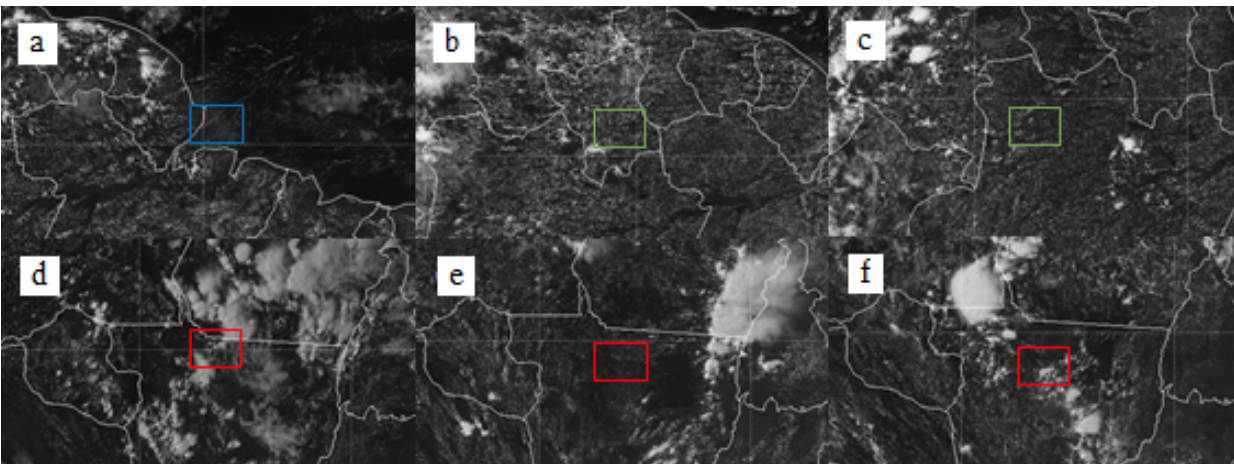
Figure 2. GOES-13 visible images for flights (a) M1, (b) RA1, (c) RA2, (d) AD1, (e) AD2, and (f) AD3. Images are approximately 1h after the profile start